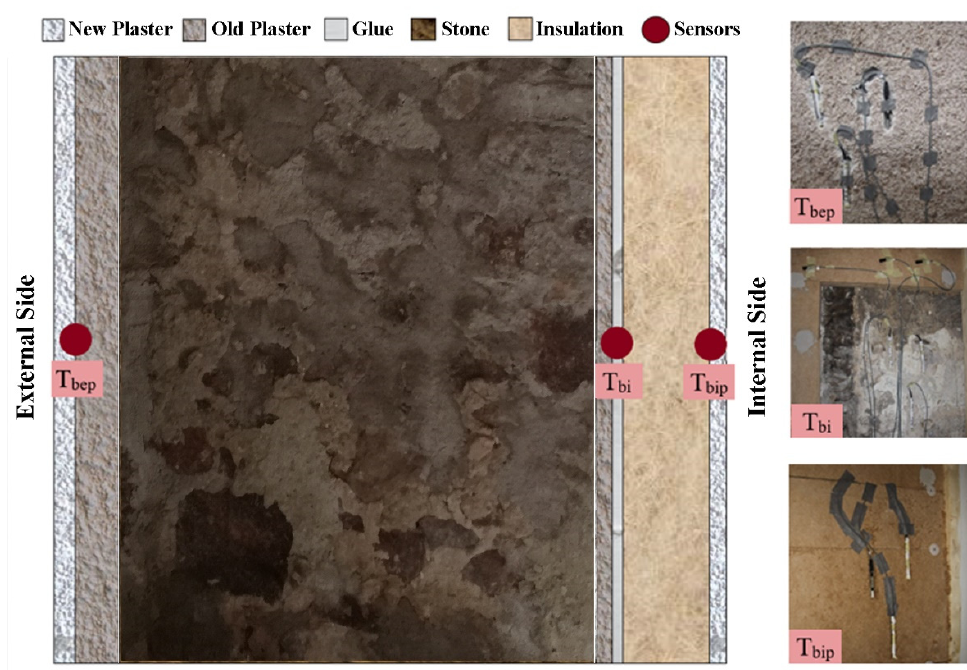
Figure 3. Monitored wall and internal sensors installed.